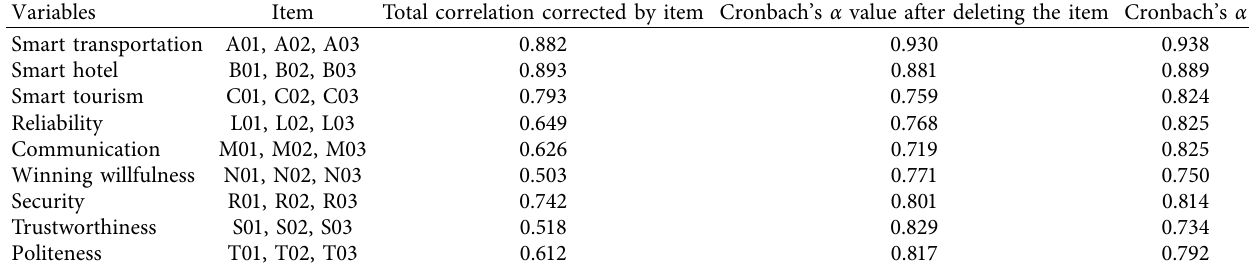
Table 1: Reliability analysis.